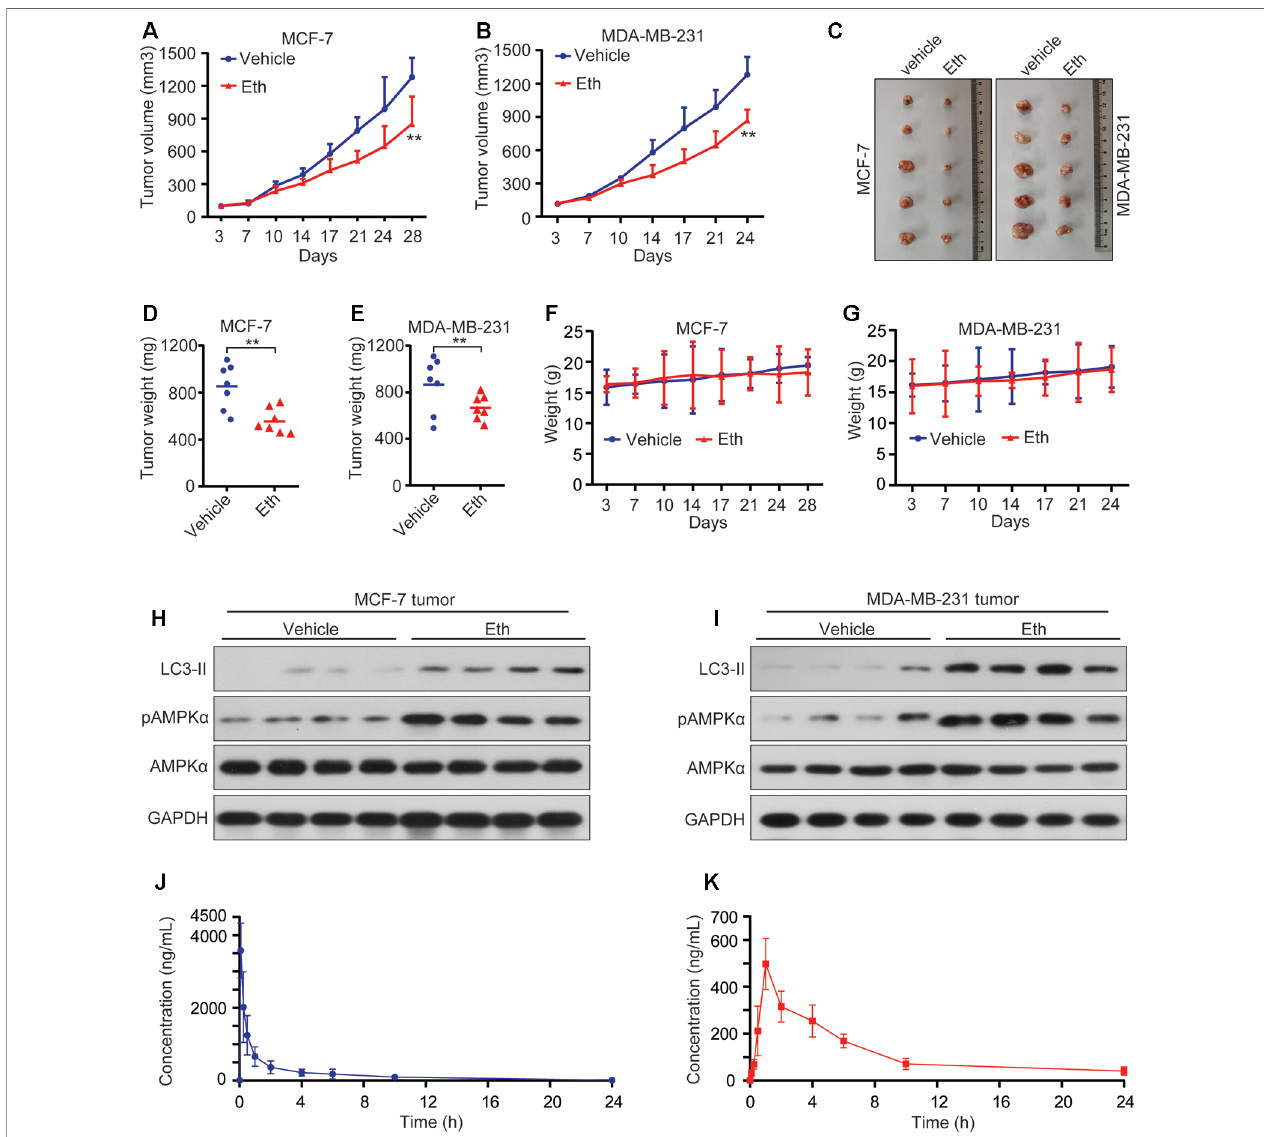
FIGURE 6 | Eth inhibits tumor growth in murine models and shows favorable pharmacokinetic pro fi les. (A – B) : Murine models were treated with vehicle, Eth (2 mg/ kg) and the tumor volumes were calculated twice a week. ** P < 0.01. (C) : Images of xenograft tumors obtained from mice with different treatment after about 4 weeks. (D – E) : Weight of the tumor from each group taken out from the sacri fi ced mice at the end of the study ** P < 0.01. (F – G) Eth treatment did not affect the murine model body weight. (H – I) : The expressions of LC3-II, AMPK a , and pAMPK a in xenograft tumor tissues were analyzed by western blot. (J) : The concentration-time pro fi les of Eth after i.v. injection (2 mg/kg) in Sprague-Dawley rats. (K) : The concentration-time pro fi les of Eth after i.g. injection (15 mg/kg) in Sprague-Dawley rats.